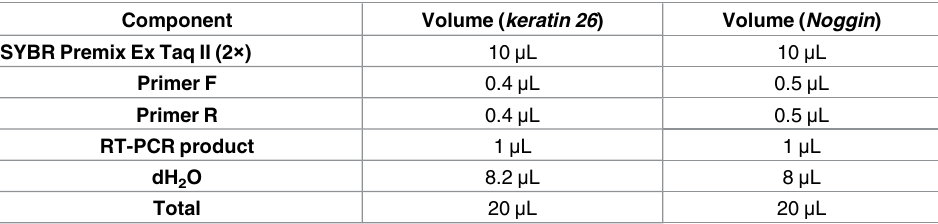
Table 2. Reaction systemsof quantitative real-time